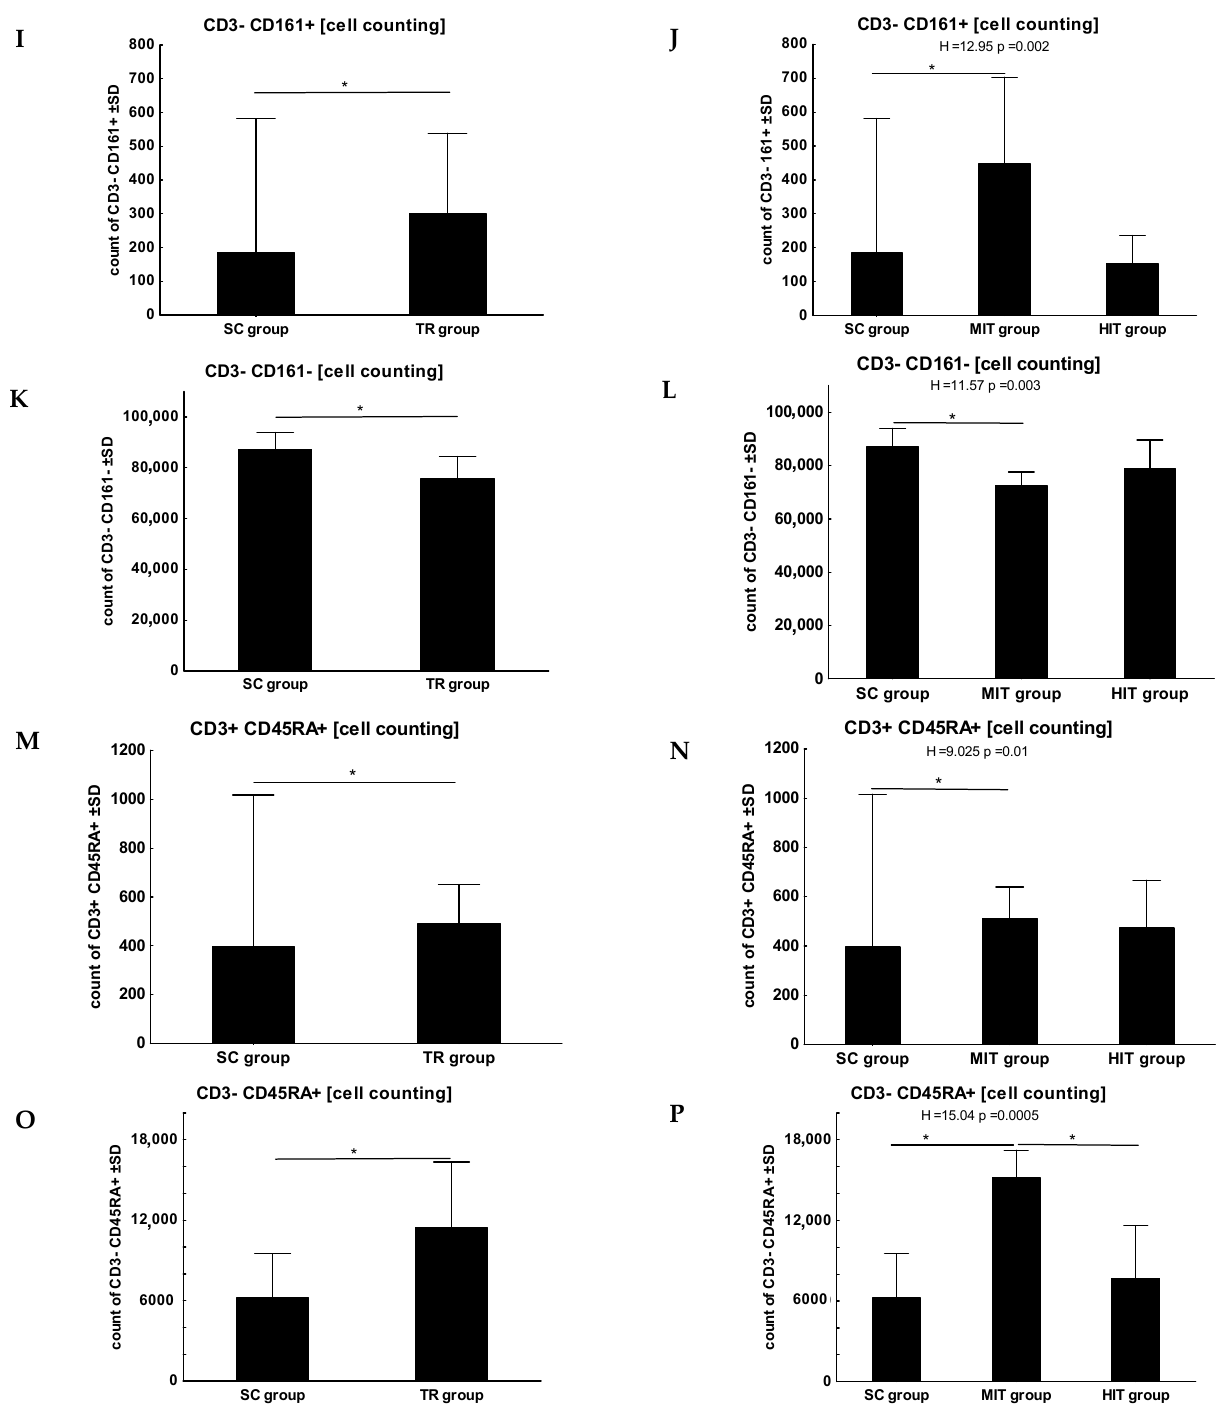
Figure 2. Characteristics of lymphocyte subpopulation: CD3+/CD4+ ( A , B ), CD3+/CD8+ ( C , D ), CD4+/CD8+ ( E , F ), CD3 − /CD11b+ ( G , H ), CD3 − /CD161+ ( I , J ), D3-/CD161 − ( K , L ), CD3+/CD45RA+ ( M , N ) and CD3 − /CD45RA+ ( O , P ) in the study groups. Measurements included: cell counting; the results were expressed as a cell number. Data were analyzed using the Mann–Whitney U test to compare the sedentary group (SC, n = 14) with the combined training groups (TR = MIT + HIT, n = 24) and the Kruskal–Wallis test was applied for the analysis in particular groups (SC, n = 14, MIT, n = 12, HIT, n = 12). *—the level of divergence between groups ( p < 0.05); Mann–Whitney U test, Kruskal–Wallis test(post hoc).